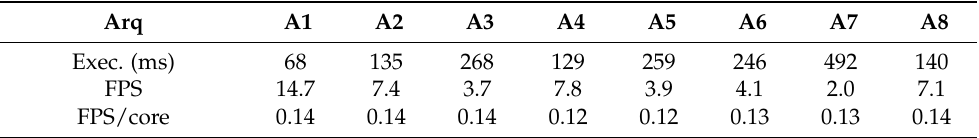
Table 8. Tiny-YOLOv3 execution times on the proposed architecture with different configurations of the core